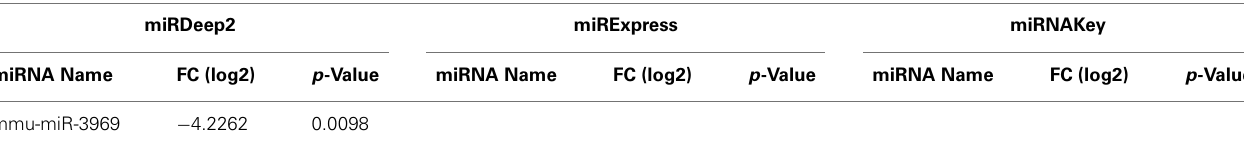
Table 3 | Differentially expressed miRNAs in the Gastrocnemius muscle detected by DESeq for Sham-Surgery vs. nerve crush. miRDeep2